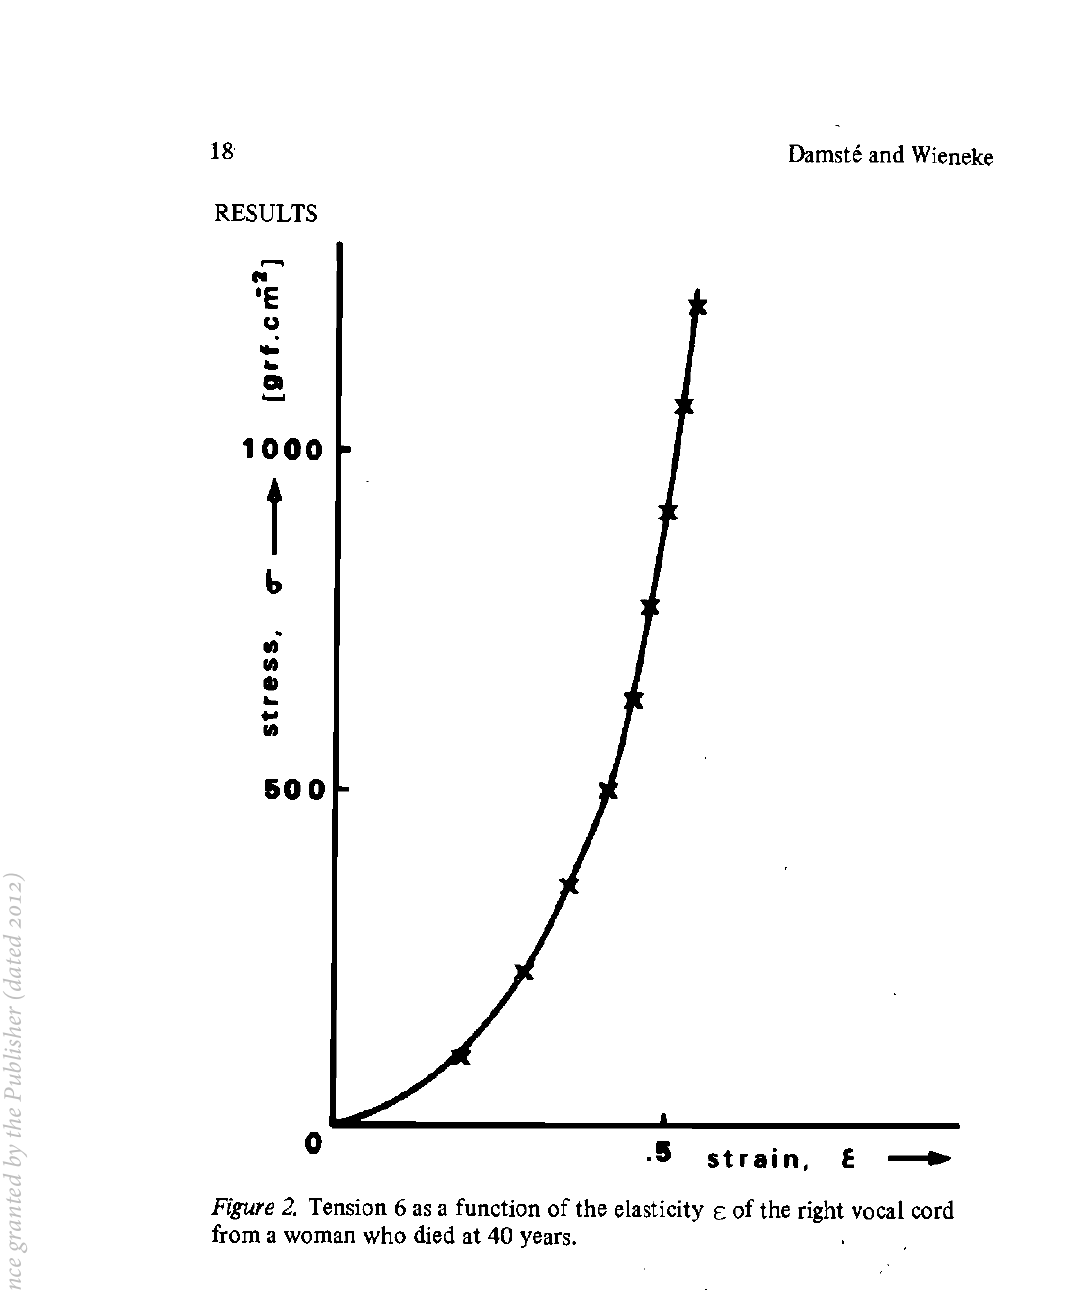
Figure 2. Tension 6 as a function of the elasticity ε of the right vocal cord from a woman who died at 40